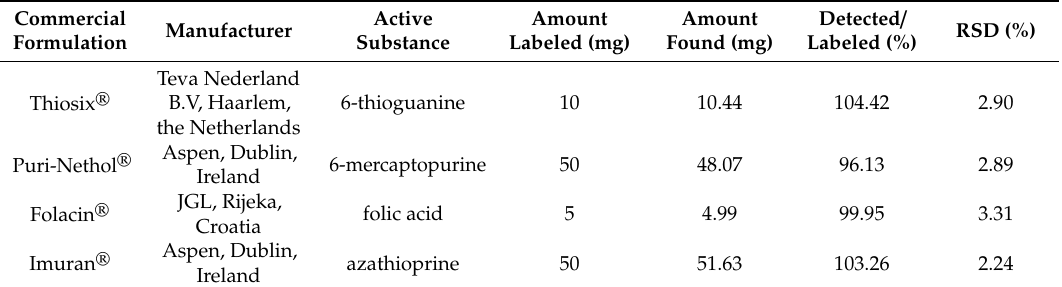
Table 6. Results of analyses of marketed formulations ( n =